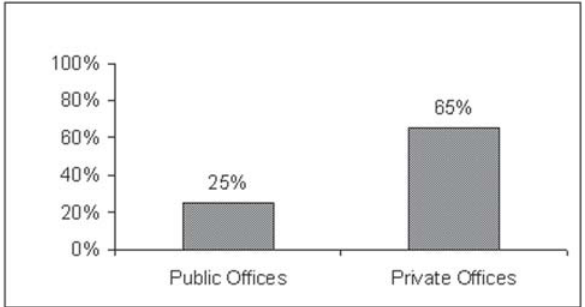
FIGURE 1- Distribution of dental professionals according to the supply of spectacles to the patients. Araçatuba/SP, 2003